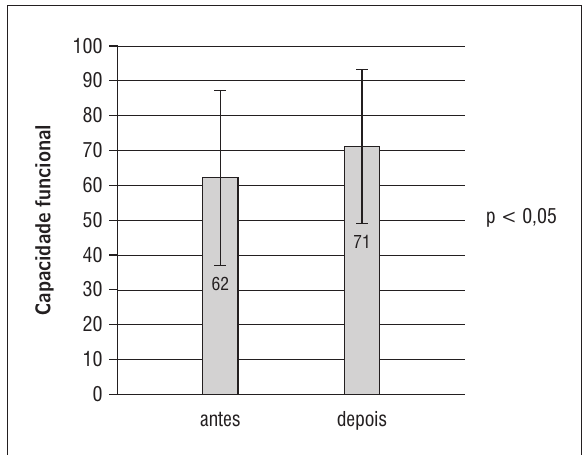
Figura 1 - Média e desvio-padrão da capacidade funcional dos pacientes antes e depois do protocolo fisio- terapêutico (n = 27; p < 0,05)